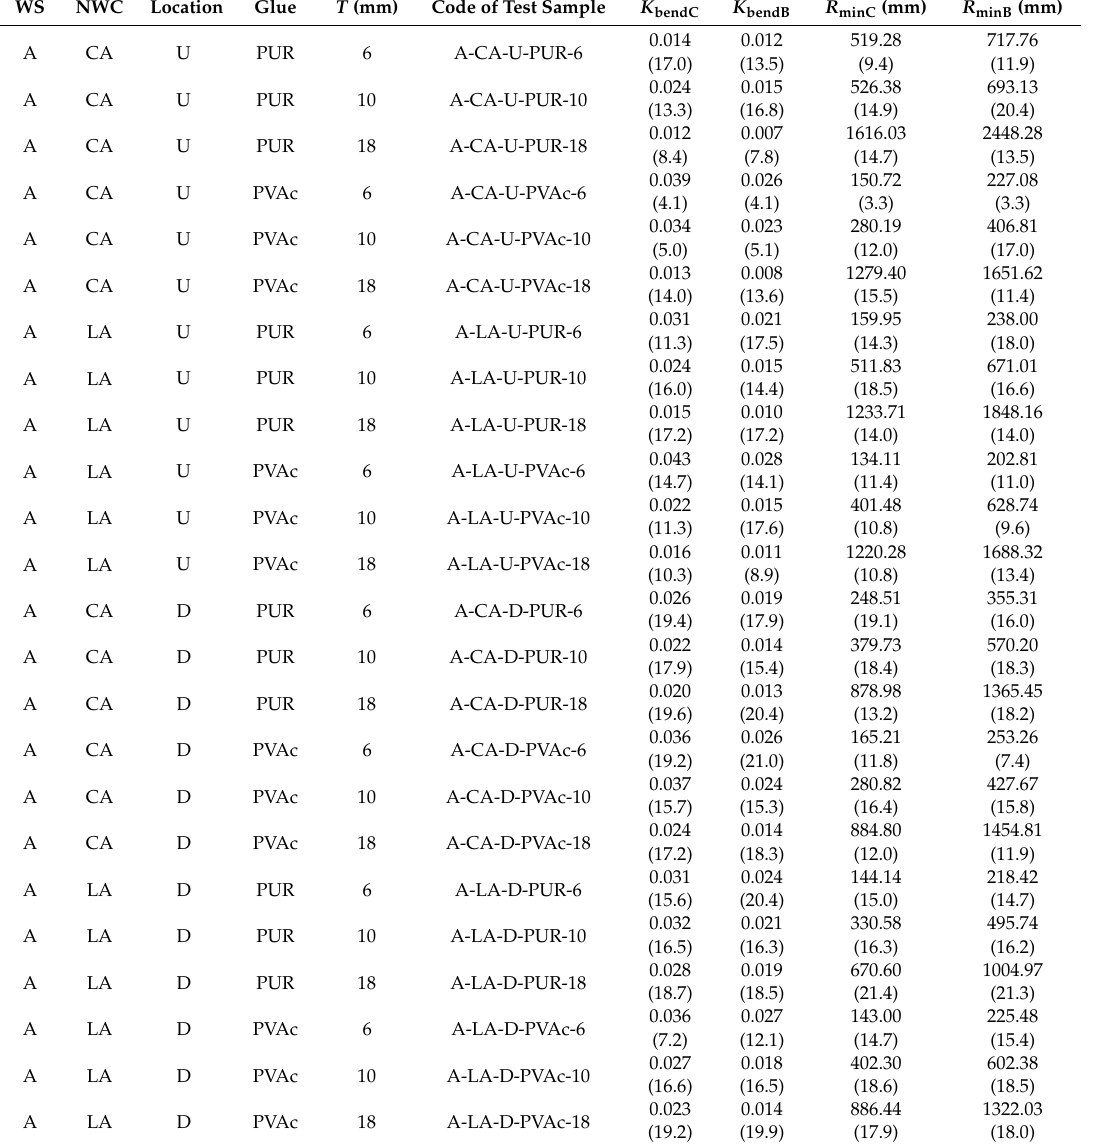
Table 1. Values of bending characteristics and the coe ffi cients of variance of layered aspen